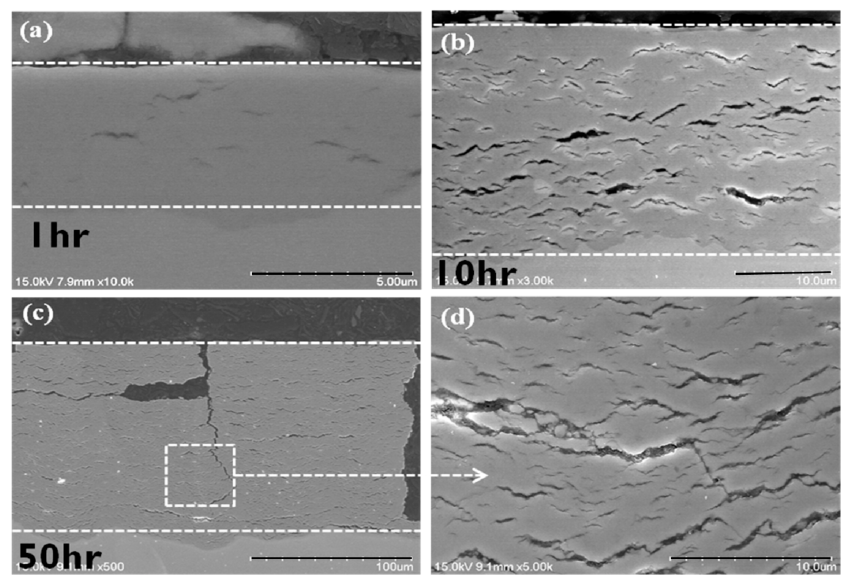
Figure 7. FE-SEM micrographs of the as-received Zircaloy-4 cladding specimens oxidized at 650 °C for ( a ) 1, ( b ) 10, and ( c ) 50 h. ( d ) Magnified image of the box in ( c ) for clearly illustrating the features of the oxide scale.